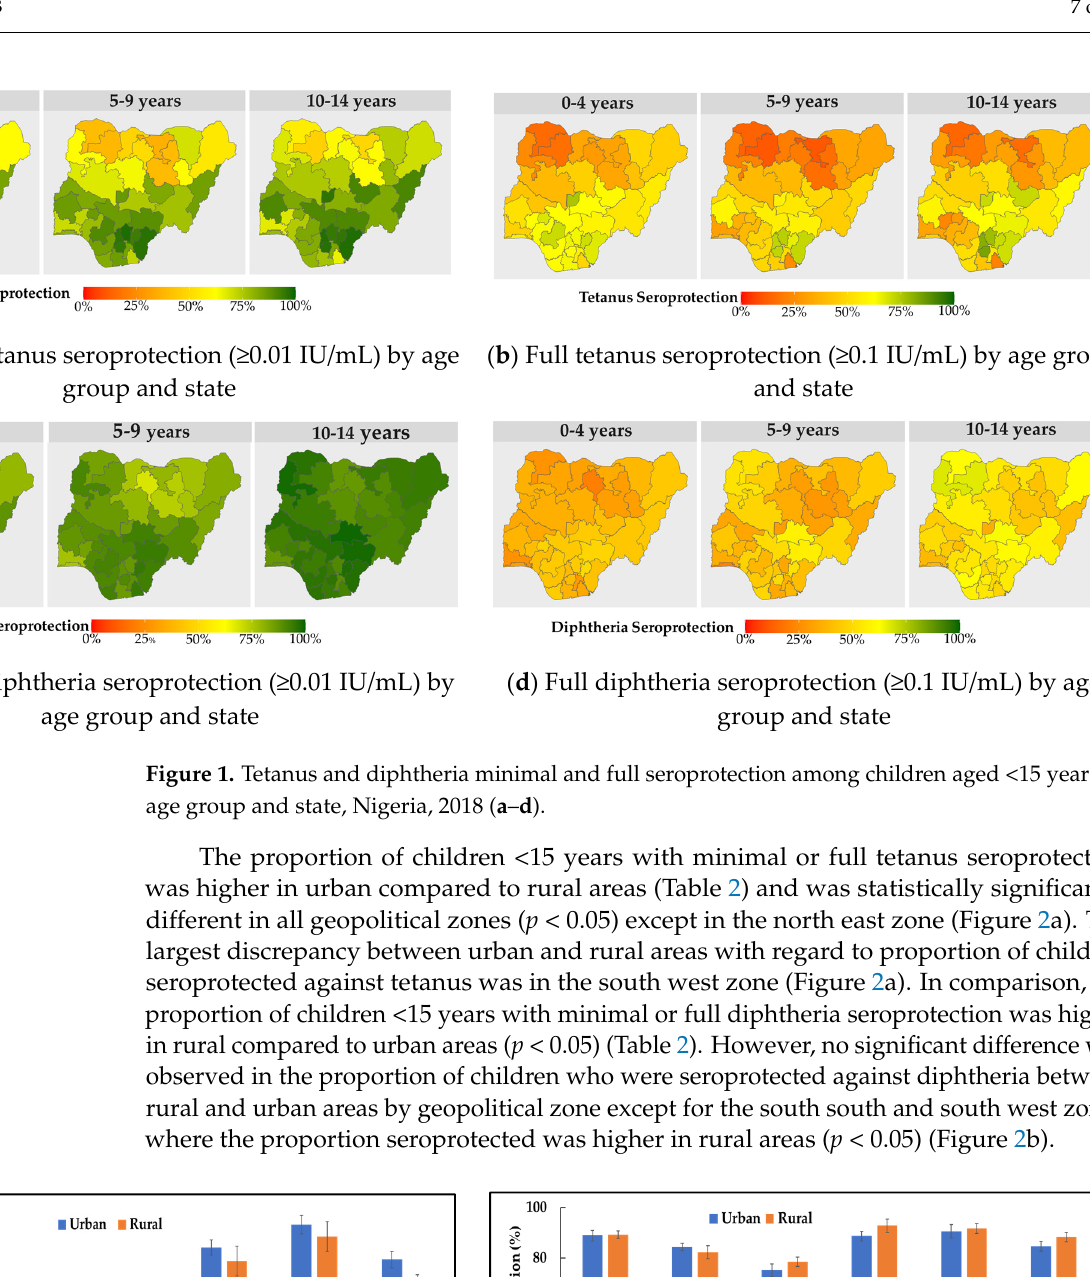
Figure 2. Tetanus and diphtheria minimal seroprotection ( ≥ 0.01 IU/mL) among children aged <15 years by zone and location, Nigeria, 2018 ( a , b ).